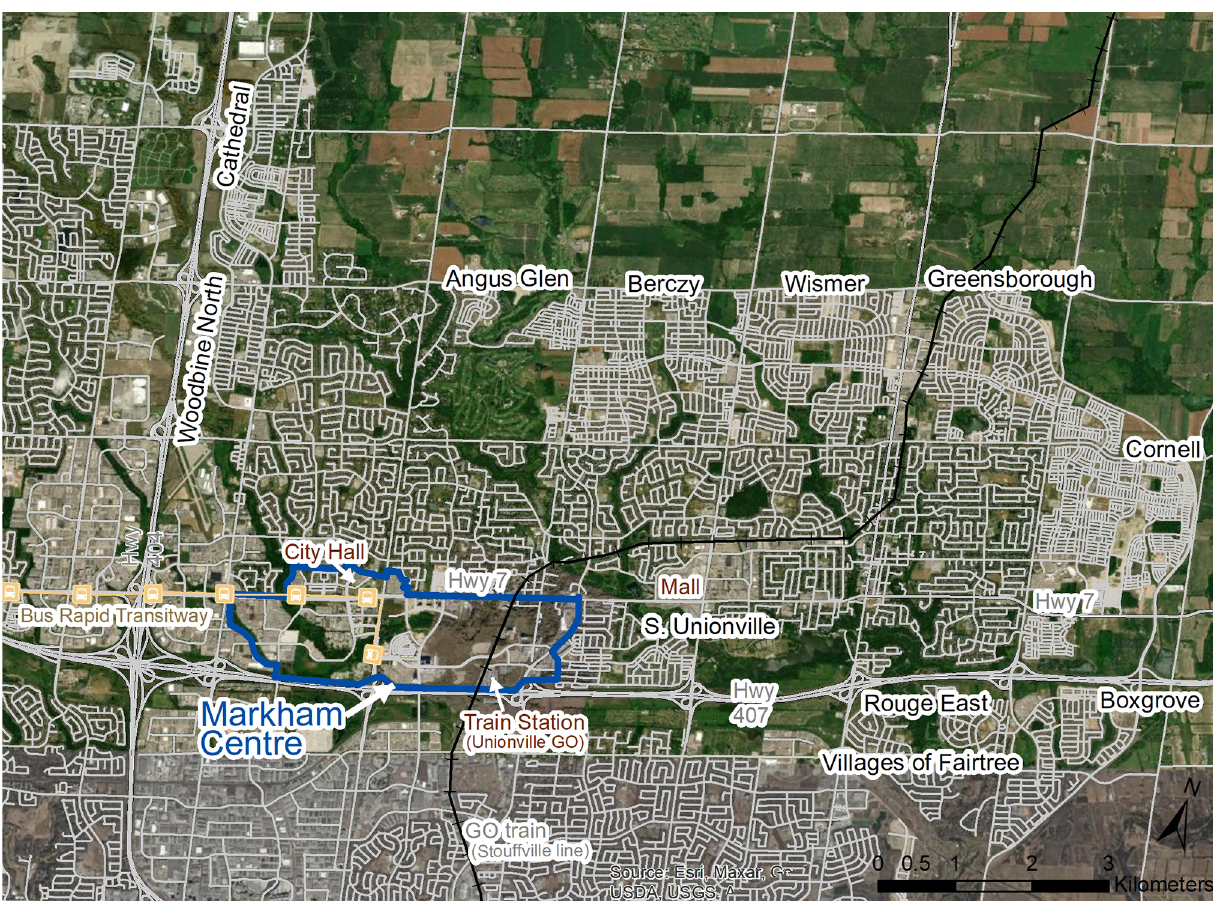
Figure 2. Markham’s new urbanist development blocks. Source: Author, based on open source data from the Province of Ontario, York Region, and City of